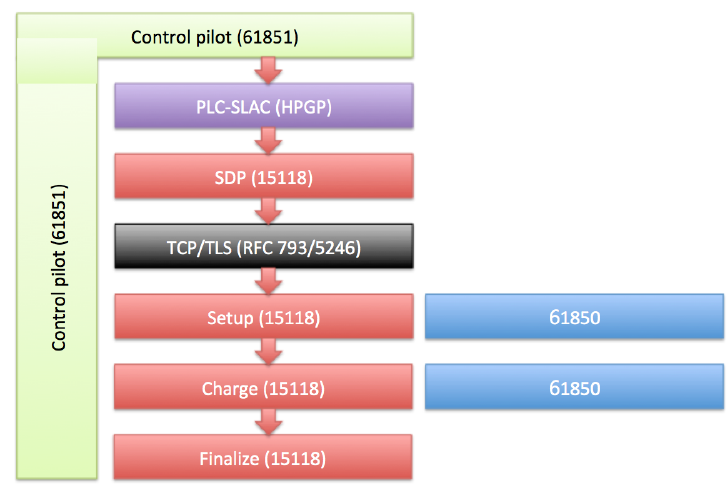
Figure 4. Charging procedure overview with relevant standards in parenthesis.